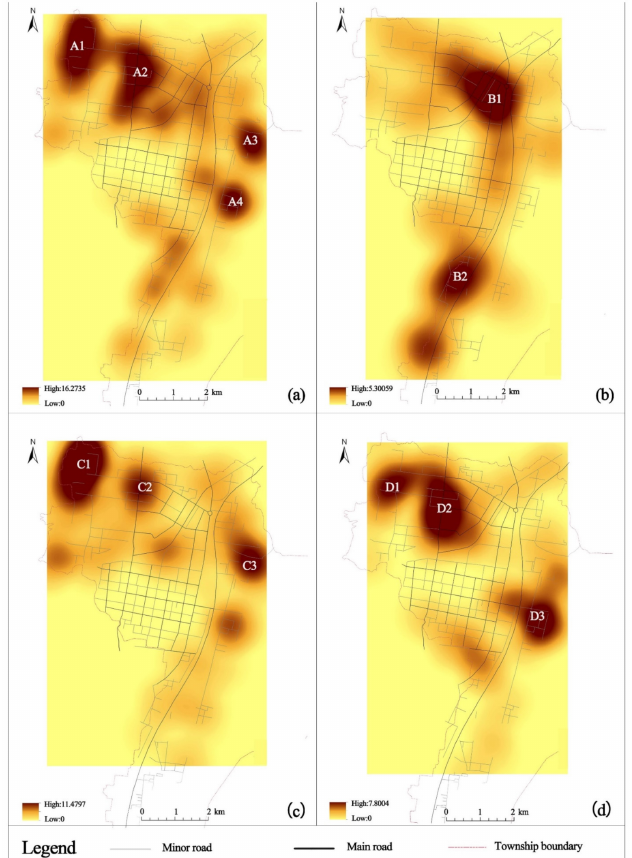
Figure 7. Distribution of nuclear density of urban inefficient land use sites in Xincheng. (( a ). Inefficient land; ( b ). Inefficient residential land; ( c ). Inefficient industrial land; ( d ). Inefficient commercial